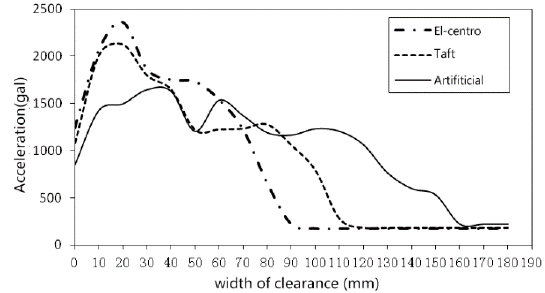
Figure 10. Maximum acceleration value changes with clearance width in model B.